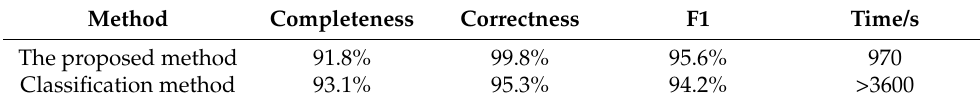
Table 4. Comparison with classification method [31] in terms of point-based